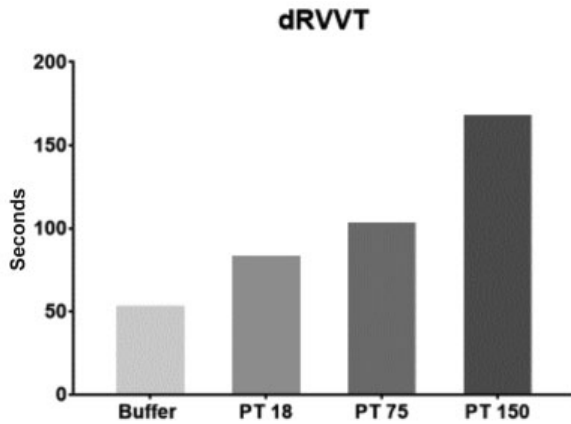
Fig. 2 Diluted Russell viper venom time (dRVVT) of patient ’ s plasma without addition of human prothrombin (buffer) and after addition of human prothrombin in increasing amounts (18, 75, 150 µg/mL fi nal concentration in patient ’ s